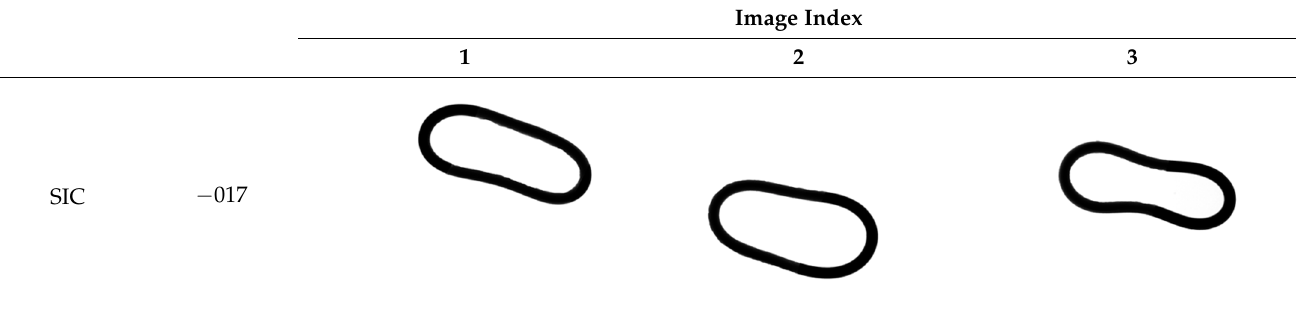
Table 4. Table of DPS (database of photometric stereo model) with SIC (size identification code) and image index.